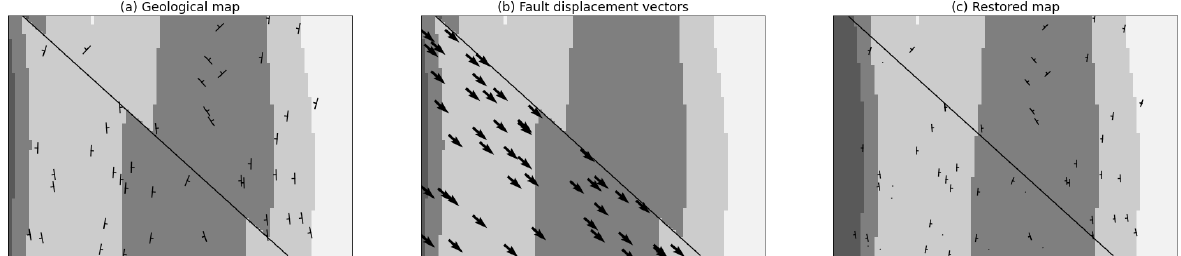
Figure 10. Geological map showing (a) structural observations for bedding, (b) interpolated fault restoration vectors and (c) a restored